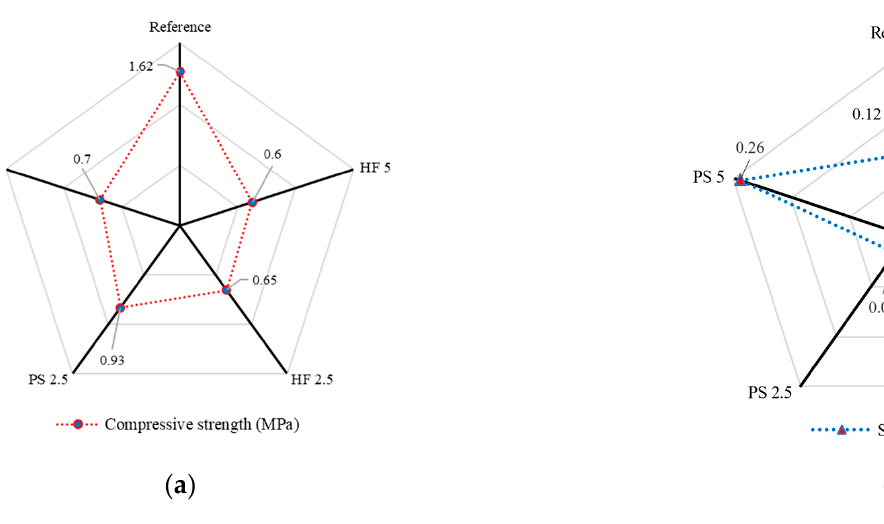
Figure 11. ( a ) Compressive strength of fiber mortar; ( b ) standard deviation.